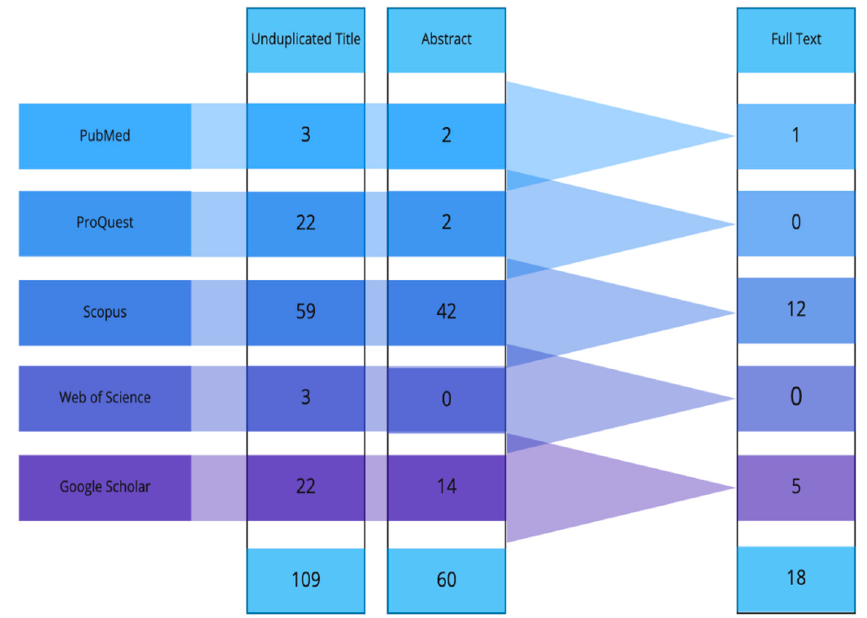
Figure 2. Filtering studies based on the title, abstract, and full text.